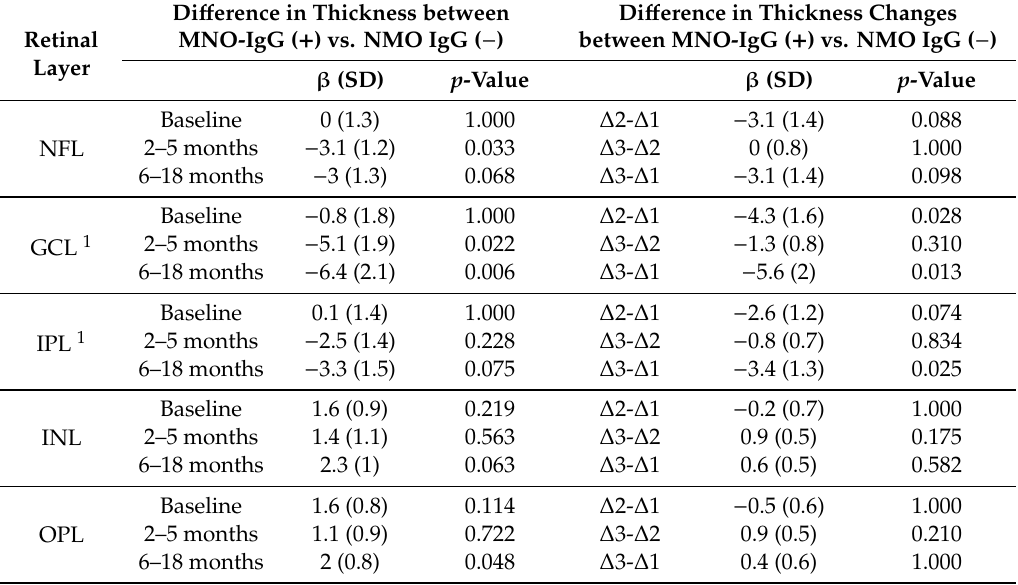
Table 3. E ff ect of NMO-IgG on the change in thickness of each Table 3. Effect of NMO-IgG on the change in thickness of each layer.